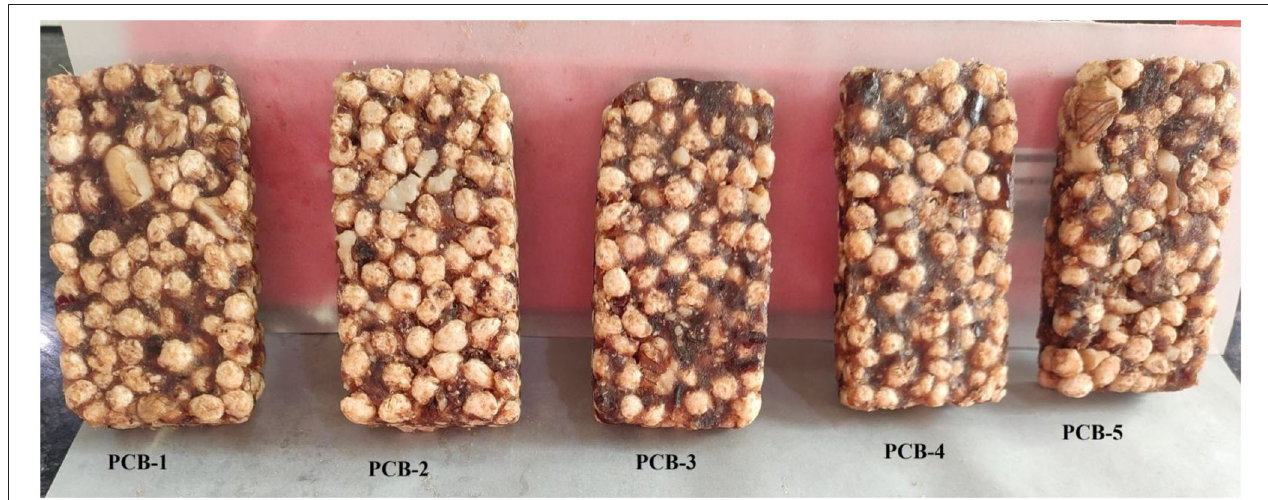
FIGURE 1 | Images of pregelatinized whole grain-based cereal bar enriched with Indian horse chestnut flour, date paste, and walnut grits.